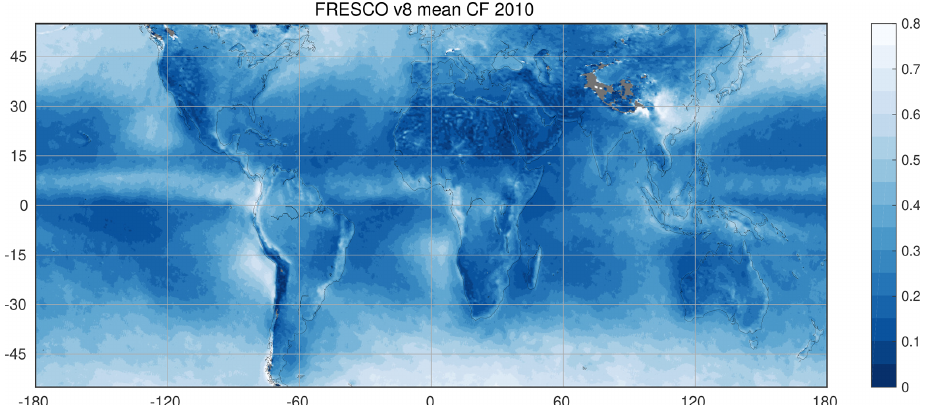
Figure F6. Same as Fig. 14 but showing the 1-year average of the FRESCO v8 cloud fraction measurements recorded in 2010. Areas without data are plotted in gray.